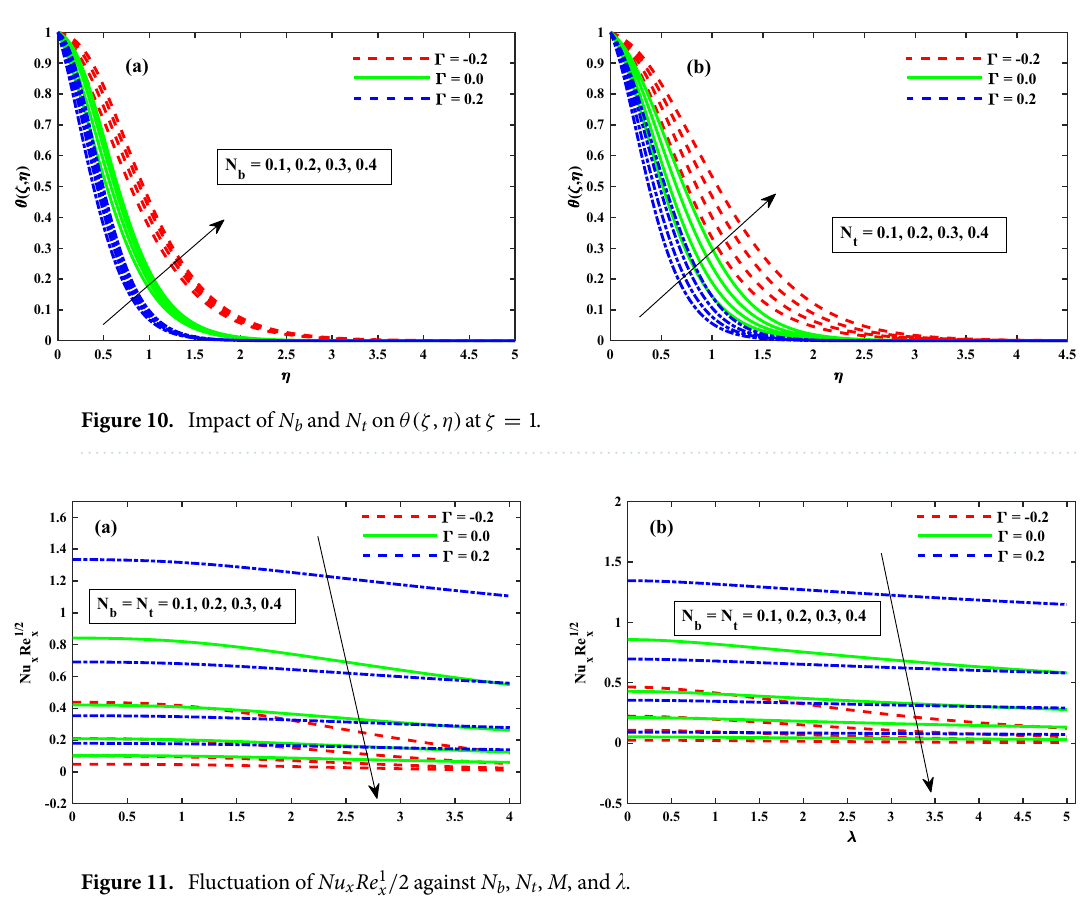
Figure 11. Fluctuation of Nu x Re 1 x / 2 against N b , N t , M , and (cid:31)